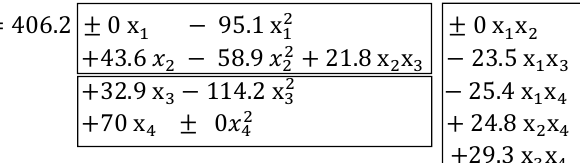
Figure 3. Thixotropy of the